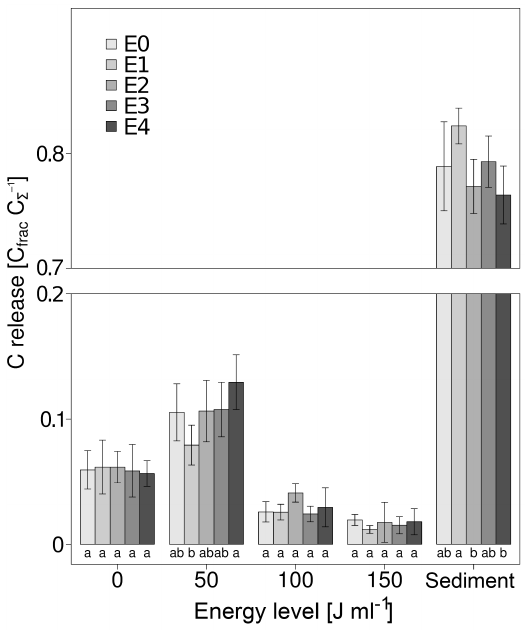
Figure 2. Relative POC release of treatments (E0, E1, E2, E3, E4) at different energy levels (0, 50, 100, 150JmL − 1 , sediment), illus- trated by Tukey test characters (a, ab, b). Data are shown as mean values and standard deviations ( n =